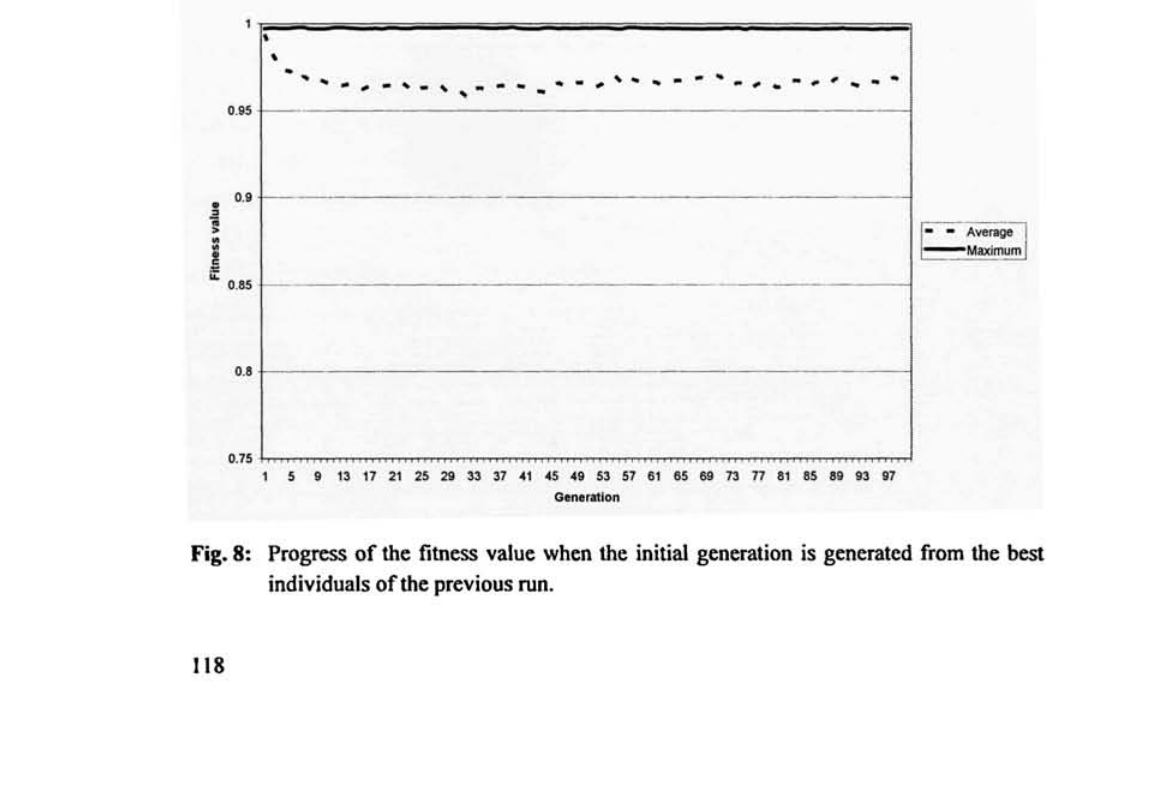
Fig. 7: Progress of the fitness value when the initial generation is partially random.